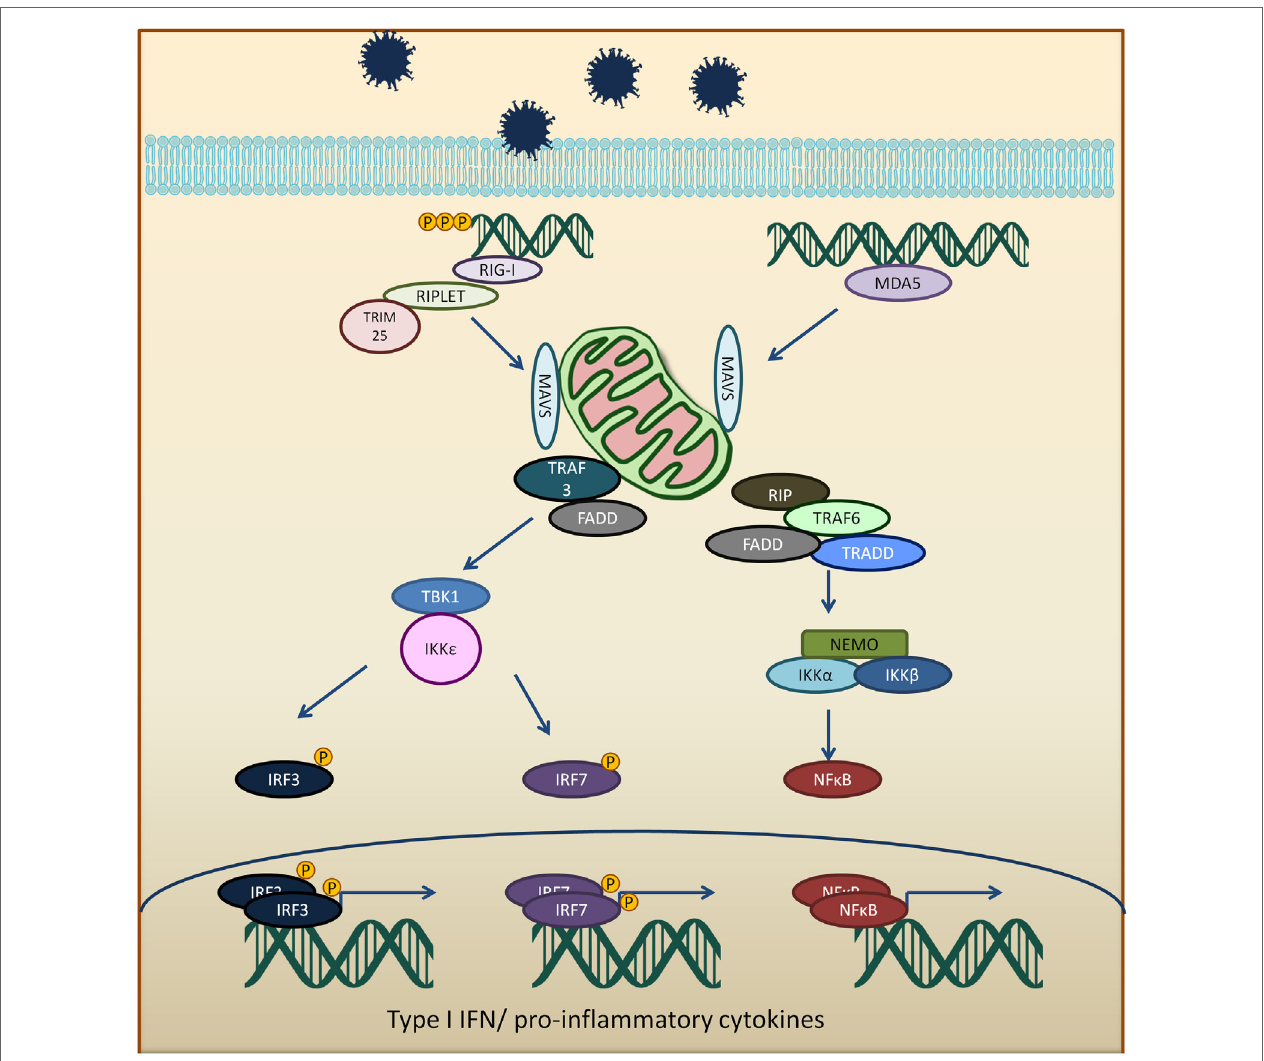
FiGURe 1 | Viral RNA is recognized by RIG-I-like receptors (RLRs), RIG-I, or melanoma differentiation-associated protein 5 (MDA5). Activated RLRs interacts with mitochondria antiviral signaling protein (MAVS) adapter protein via CARD–CARD interactions. Activated MAVS then interacts with tumor necrosis factor receptor- associated factors 3 (TRAF3), tumor necrosis factor receptor-associated factors 6 (TRAF6), tumor necrosis factor receptor type-1-associated death domain (TRADD), receptor interacting serine/threonine-protein kinase 1 (RIP1), Fas-associated protein with death domain (FADD), and other signaling molecules. TRAF3 activates TANK binding kinase 1 (TBK1) and I κ B kinase ε (IKK ε ), which phosphorylates interferon regulatory factors 3 and 7 (IRF3 and IRF7). The phosphorylated IRF3 and IRF7 dimerize and translocate into the nucleus to induce type 1 interferon response. On the other hand, MAVS interaction with receptor interacting serine/ threonine-protein kinase 1, FADD, TRAF6, and TRADD. TRAF 6 ubiquitinate NF-kappa-B essential modulator (NEMO) which then activates I κ B kinase and activates NF- κ B. NF- κ B transcription factor drives the expression of type 1 interferon and proinflammatory